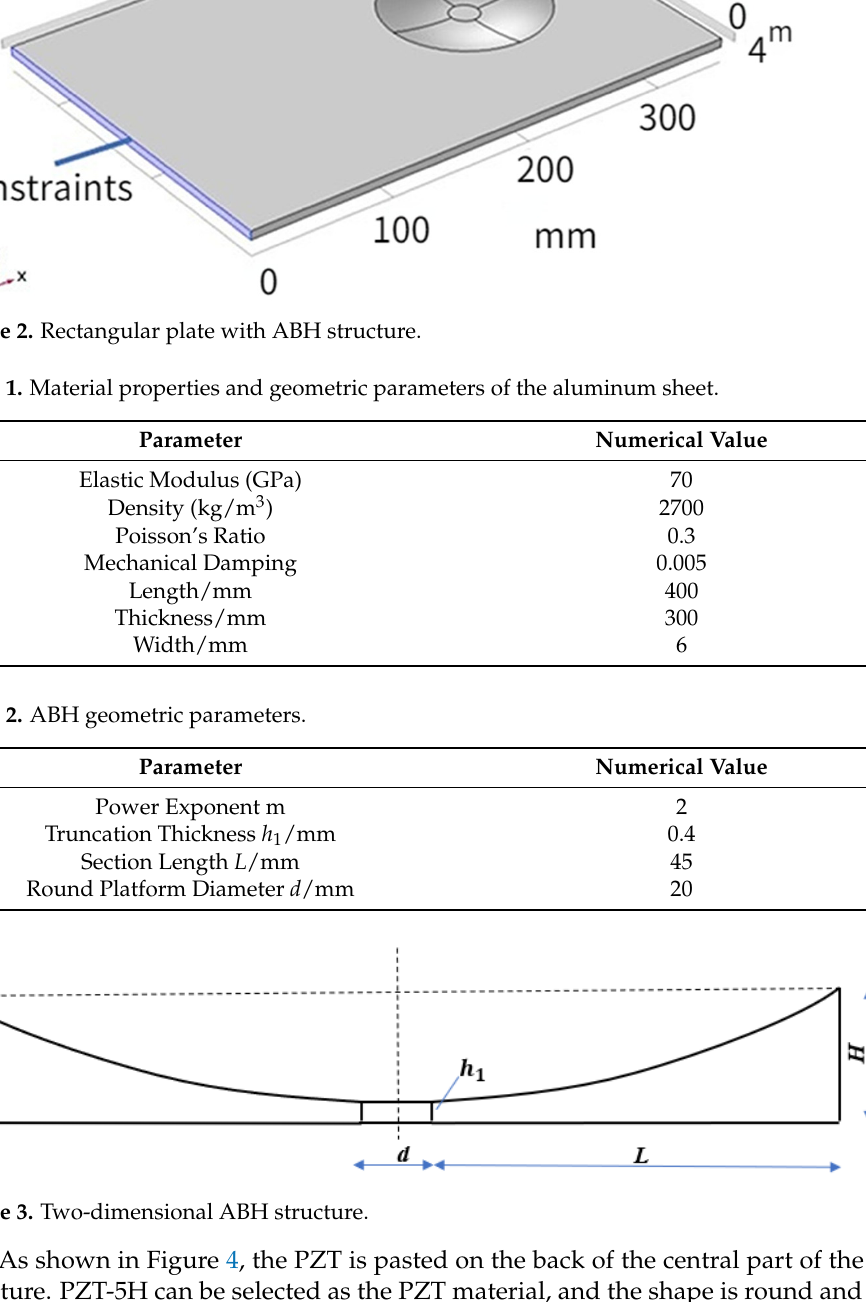
Figure 2. Rectangular plate with ABH structure.